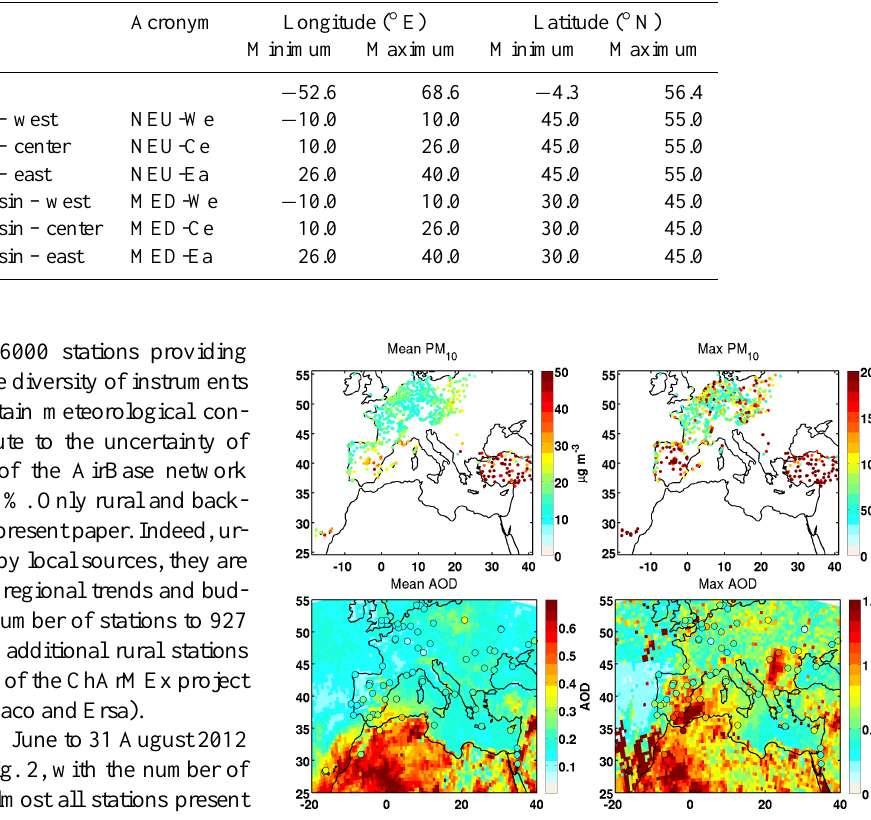
Figure 2. Summer 2012 (1 June to 31 August) daily average for sur- face PM 10 concentrations from the AirBase network and Ersa and Venaco stations (upper left) and aerosol optical depth at 550 and 500nm, respectively, from MODIS instrument and AERONET sta- tions (bottom left). Daily maximum over the period is shown in the upper right panel for surface PM 10 concentrations and the bottom right panel for aerosol optical